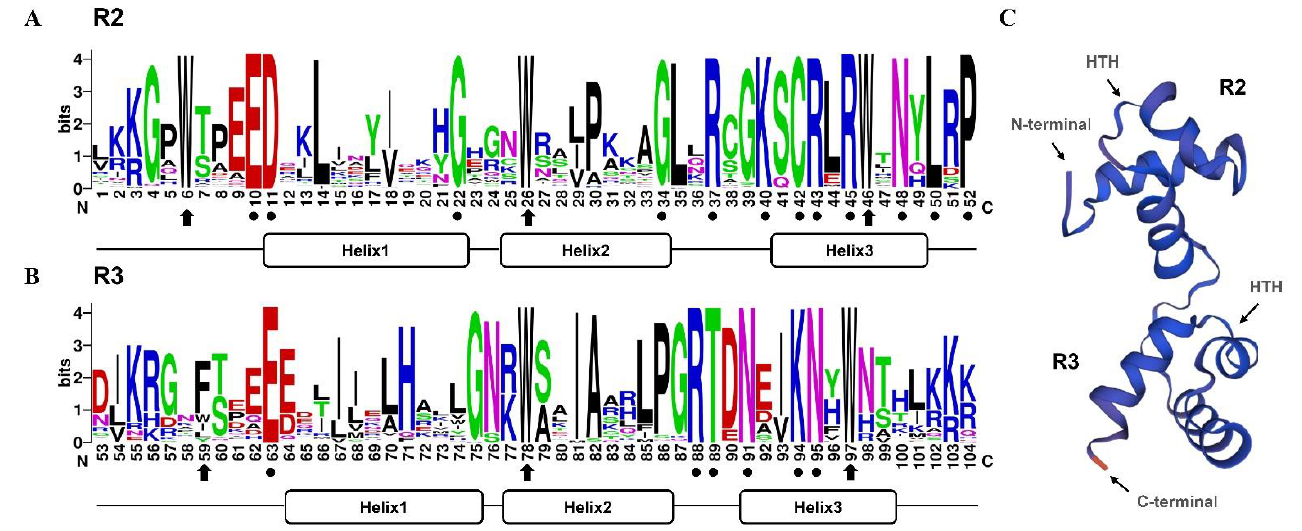
Figure 1. Sequence conservation and three-dimensional structure of 128 R2R3-MYB domains of C. oleifera . ( A ) Conservation of R2 repeats in all 128 R2R3-MYBs of C. oleifera . ( B ) Conservation of R3 repeats in all 128 R2R3-MYBs of C. oleifera . N and C on the horizontal axis represent the N-terminal and C-terminal; numbers represent locations. The bit score on the vertical axis represents how conservative each position in the sequence is, and the higher it is, the more conservative it is. Arrowheads indicate the typical, conserved tryptophan residues (W). The dots represent other conserved amino acid residues. ( C ) Three-dimensional structure of consensus sequences of all 128 R2R3-MYBs of C. oleifera . HTH stands for the helix-turn-helix structure.